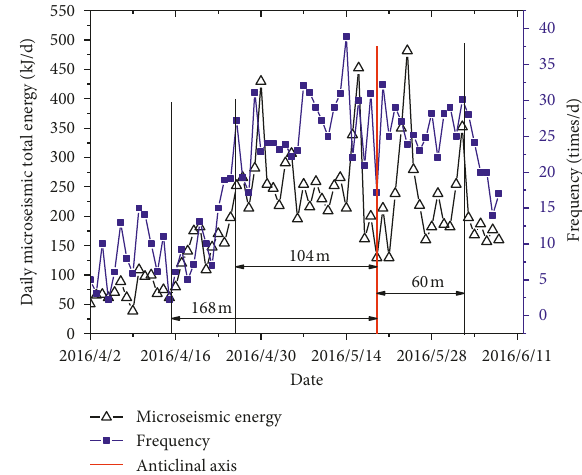
Figure 12: Statistical analysis of No. 3201 working face micro- seismic